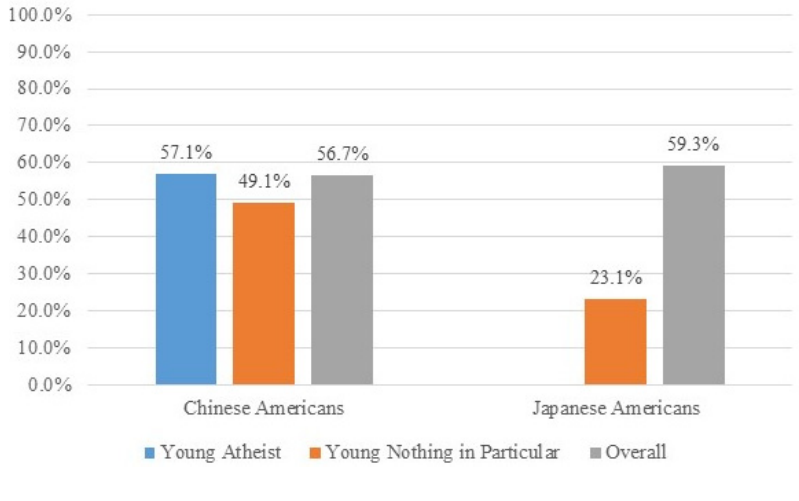
Figure 11. Top goal: being a good